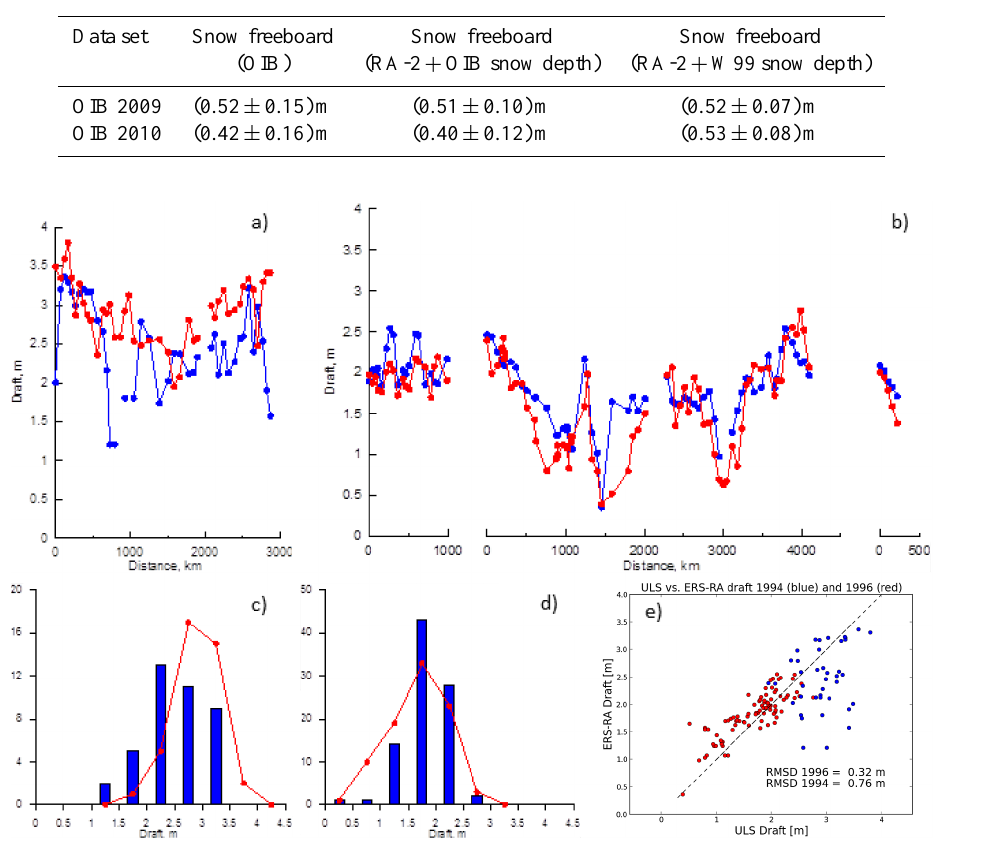
Table 3. Summary of overall mean observed (OIB) and computed (RA-2) snow freeboard using OIB or W99 snow depth; given are mean values plus/minus one standard deviation.